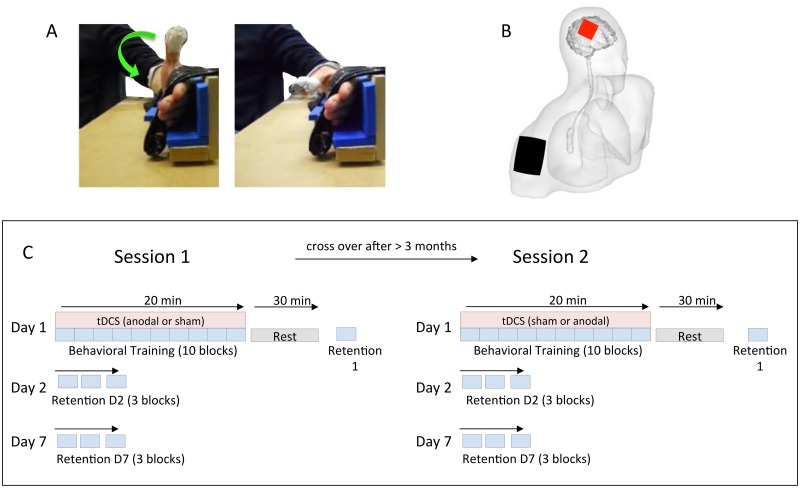
Experimental Setup.A) Subjects performed discrete ballistic thumb flexion movements with the forearm and fingers fixated. B) Constant current stimulation was delivered with the anode (red) placed over the M1 contralateral to the moving thumb and the cathode (black) over the ipsilateral shoulder. C) General experimental design.